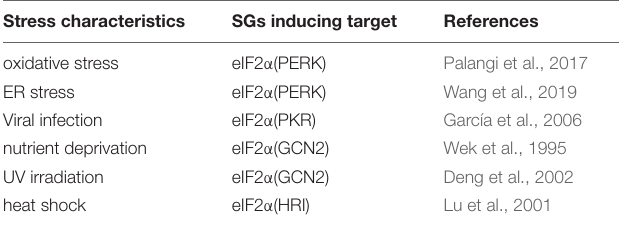
TABLE 1 | Stress classifications inducing canonical SGs